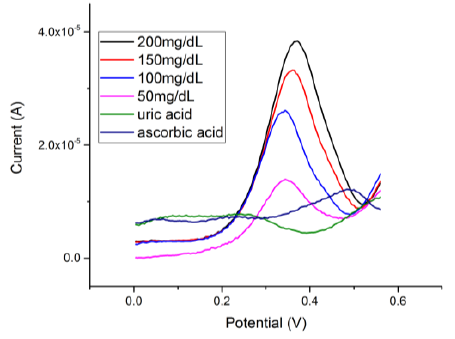
Figure 8. Interference tests from uric acid and ascorbic acid performed by DPV.